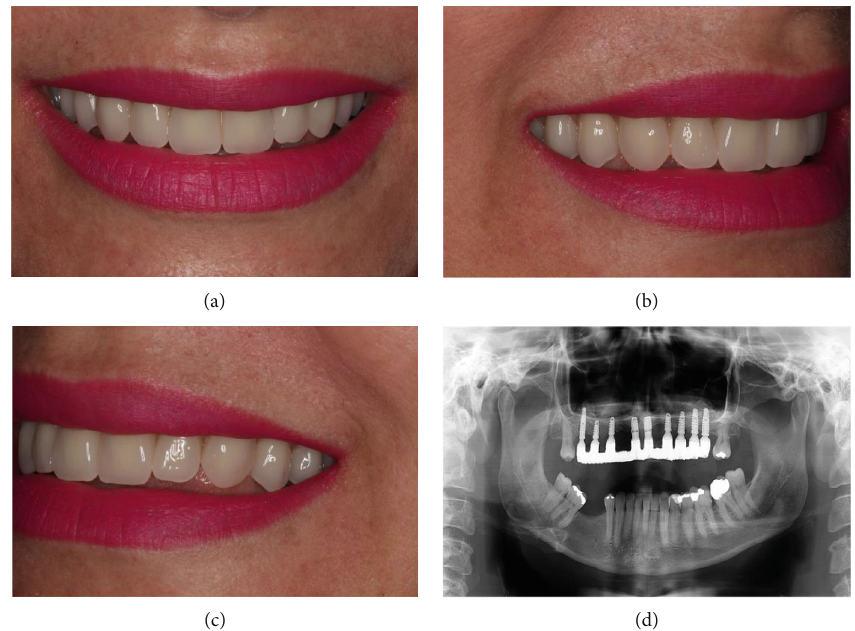
Figure 11: (a – c) One-year follow-up shows the successful functional and esthetic outcomes and proper osseointegration of the implants without any signs of